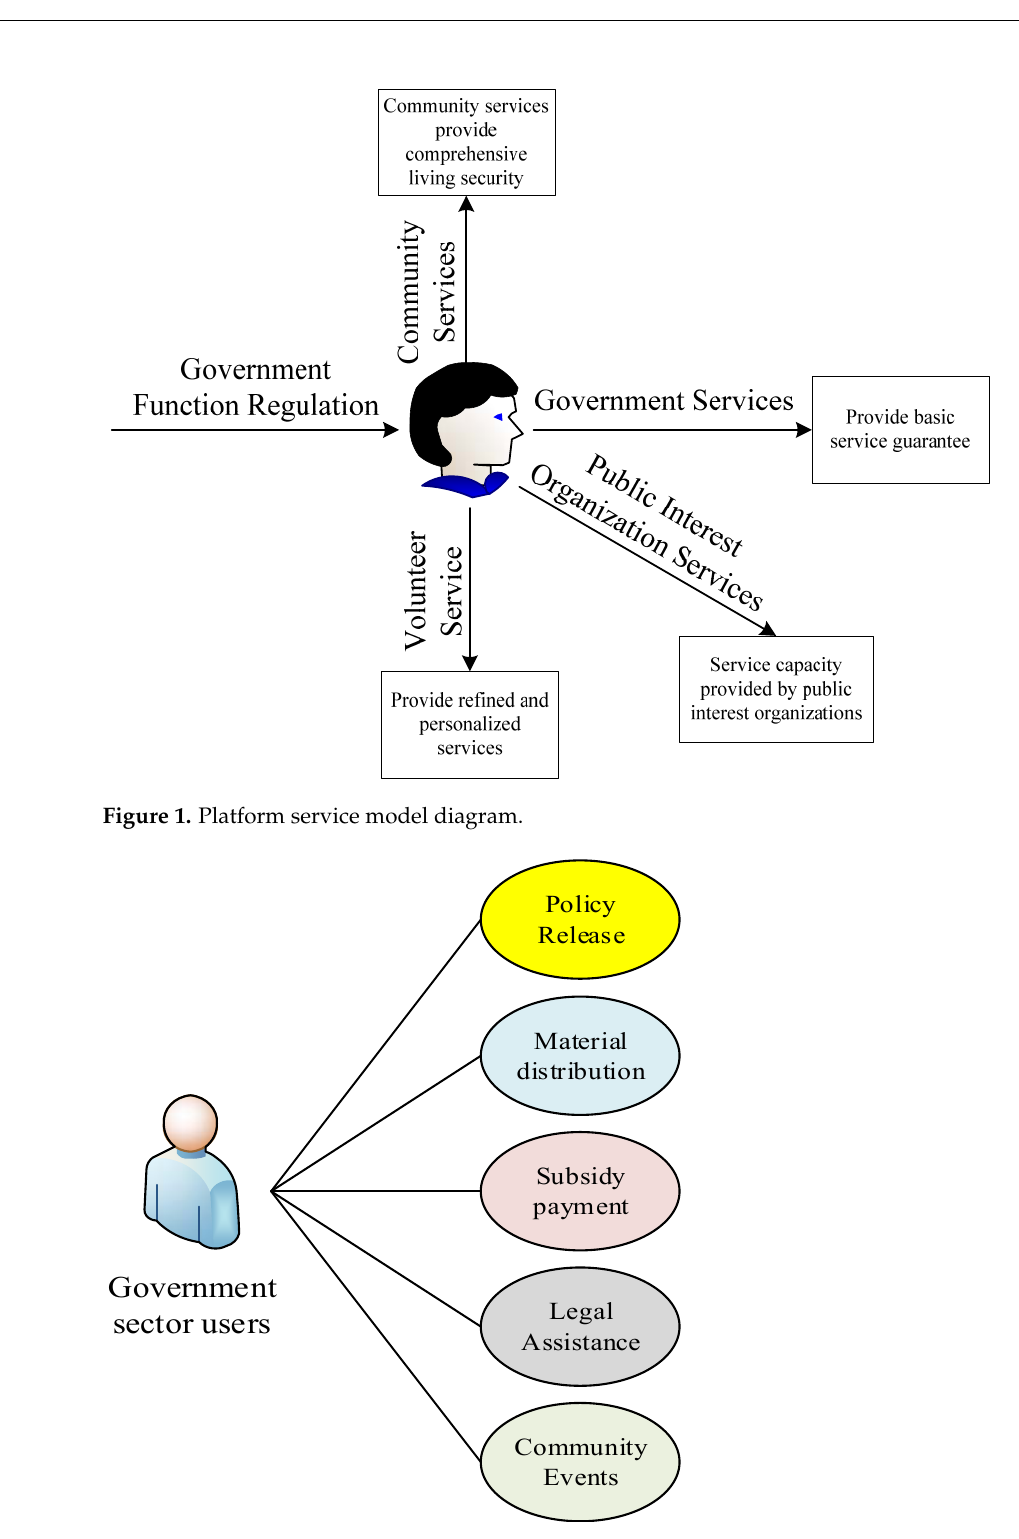
Figure 2. Diagram of government sector user requirements.